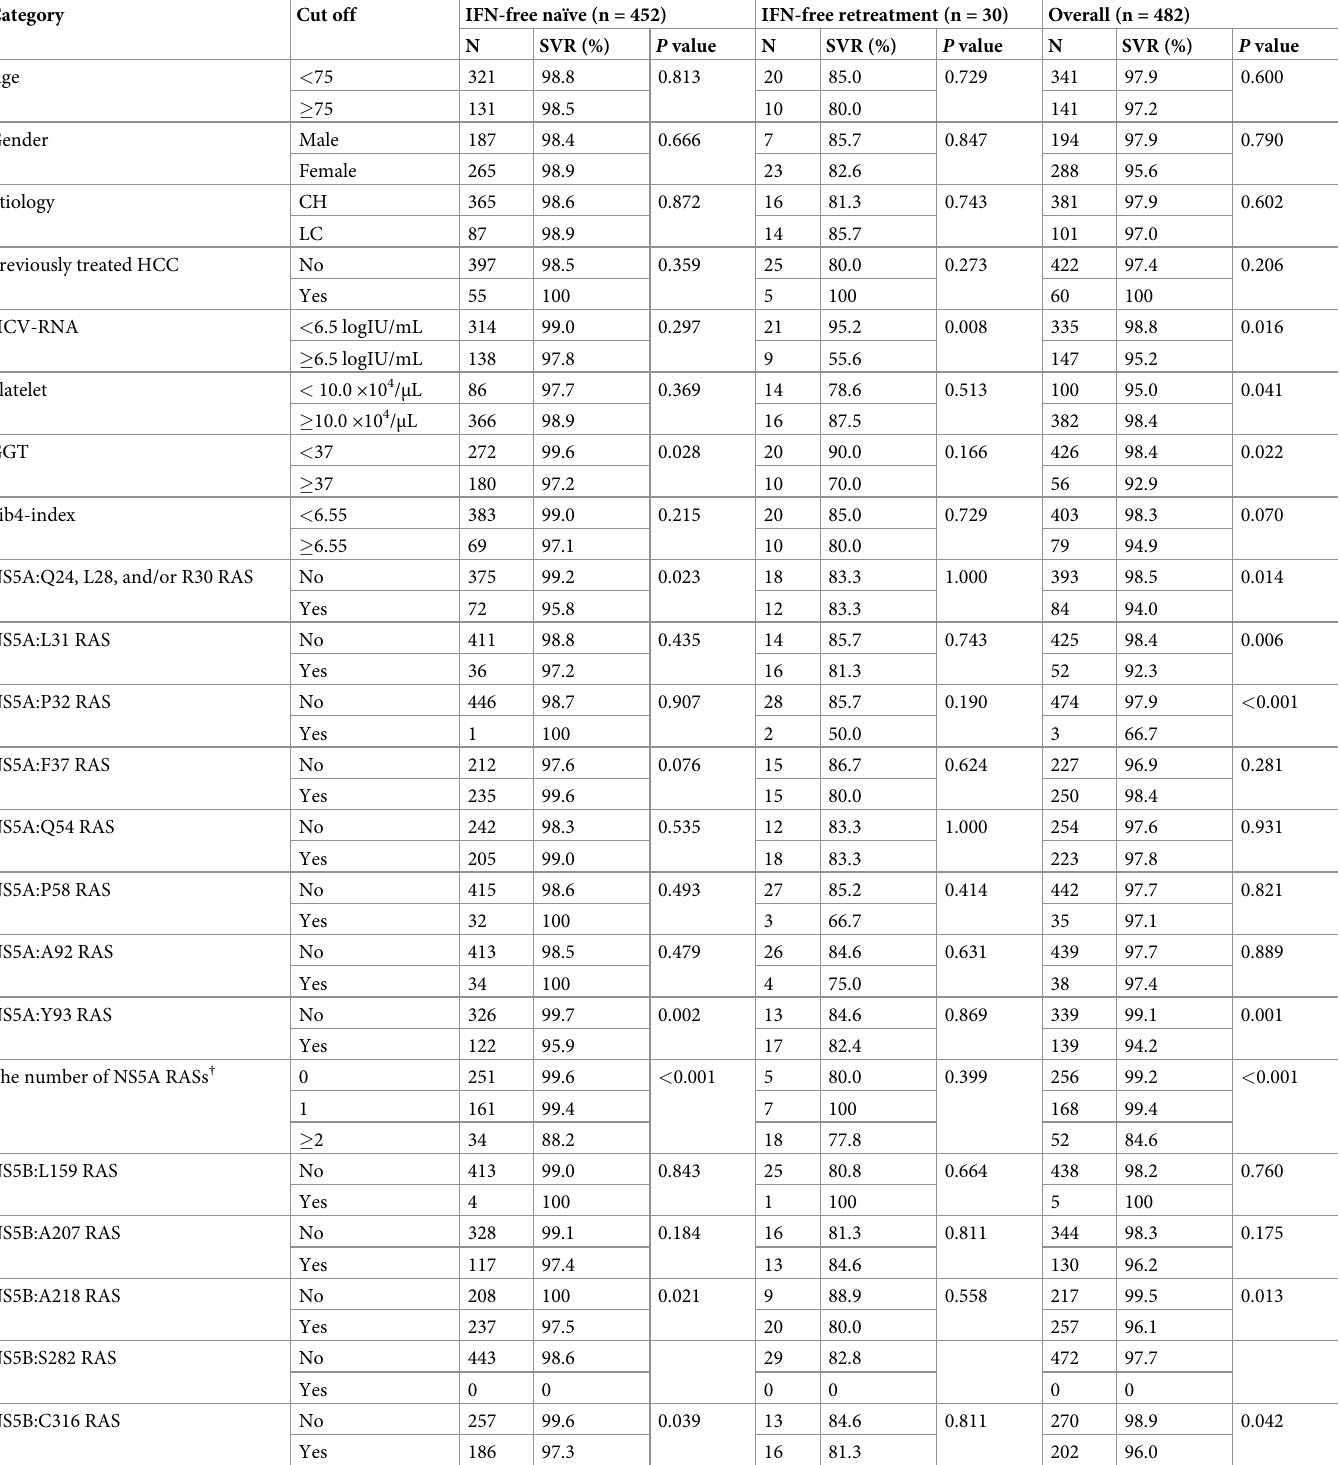
Table 3. The SVR12 rates of patients treated with ledipasvir and sofosbuvir.